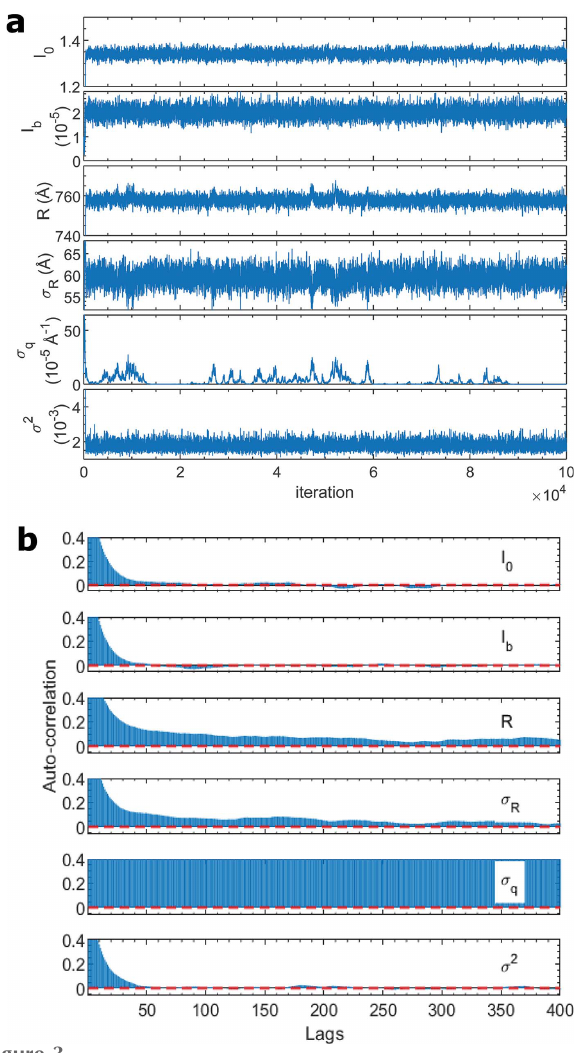
Figure 3 ( a ) Trace of the parameters sampled with random-walk MCMC. ( b ) Auto- correlation of the parameter samplings. The red dashed lines are 95% confidence